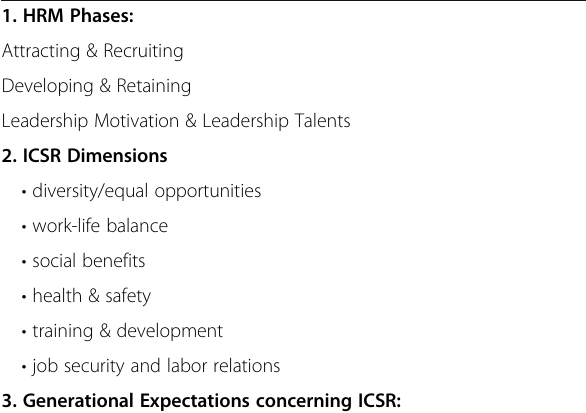
Table 1 ICSR in the HRM